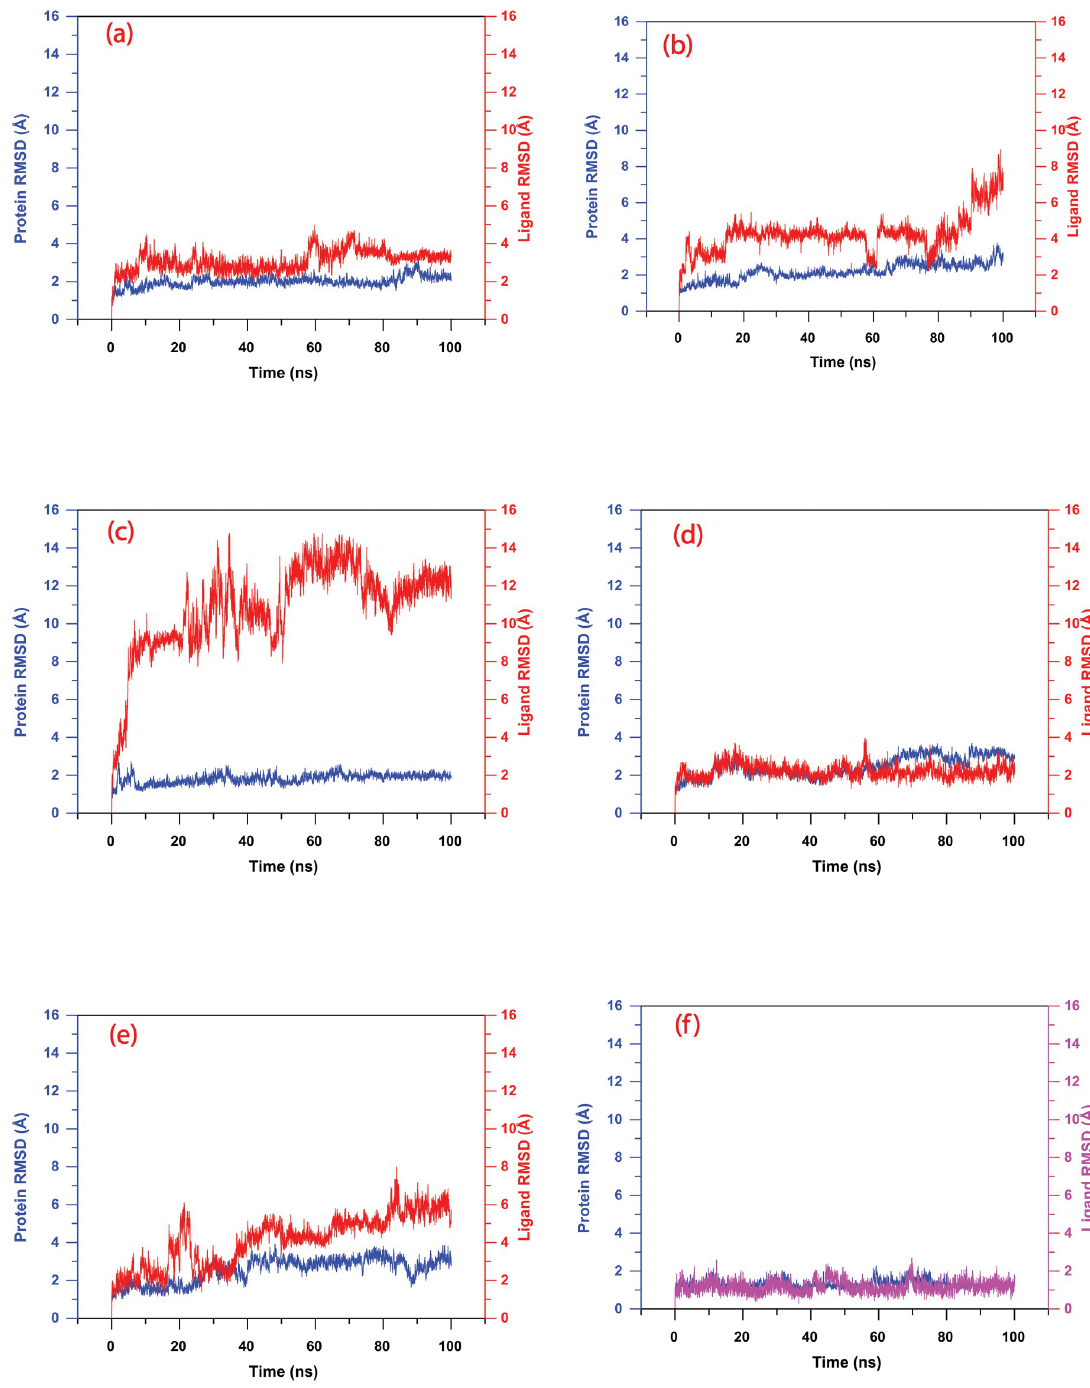
Fig 7. Root mean square deviation (RMSD) plots for (a) M pro -CHEMBL1940602 (b) M pro -CHEMBL2036486 (c) M pro - CHEMBL3628485 (d) M pro -CHEMBL200972 (e) M pro -CHEMBL2036488, and (fCH) M pro -X77 (control), calculated over the period of 100 ns MD